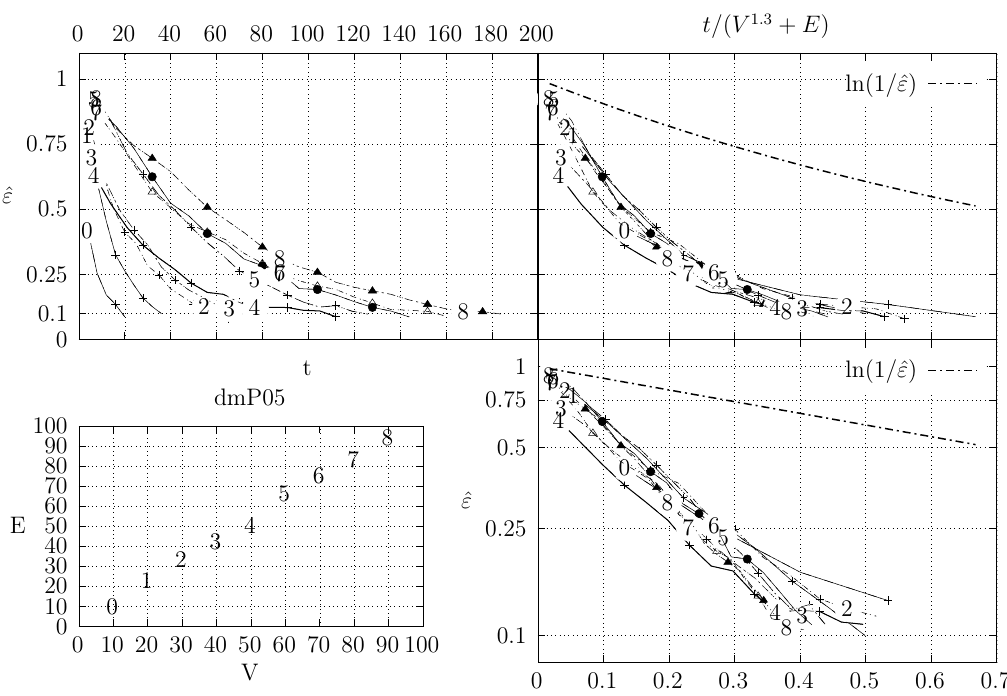
Figure 22. Estimation of variation distance as a function of the number of iterations for dmP graphs (see Section 4.3.1 for details).